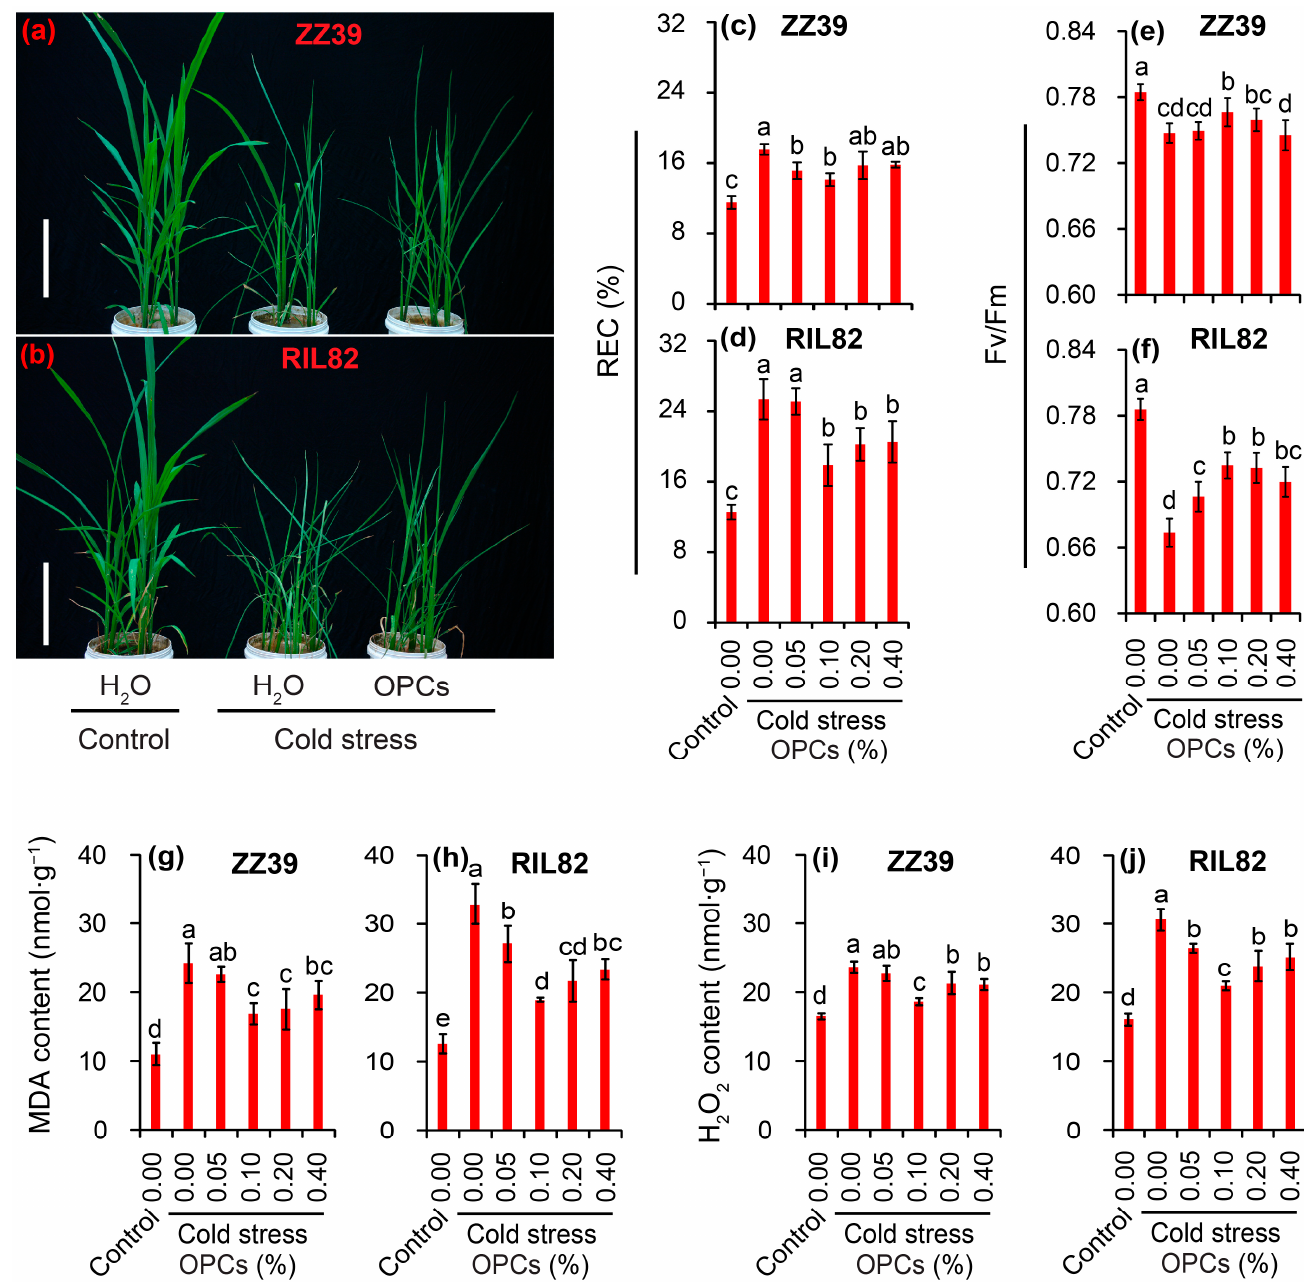
Figure 3. Transcriptome analysis on OPCs pathway in rice seedling plants under cold stress. ( A ), a schematic diagram on the synthesis OPCs; ( B ), heat map of enzyme genes involved in OPC synthesis (log 2 |FoldChange|); ( C ), Relative expression of enzyme genes involved in OPC synthesis; ( D ), OPC contents; ( E ), descriptive model of the relationships between OPCs, the antioxidant system, and en- ergy homeostasis in plants under cold stress. OPCs, oligomeric proanthocyanidins. * denotes p < 0.05.